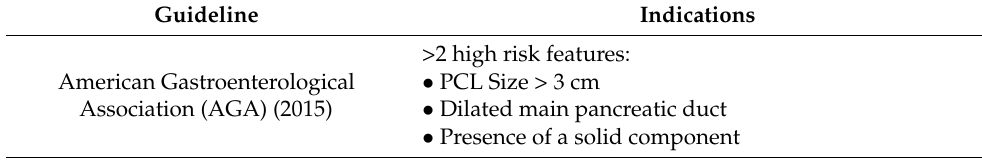
Table 1. Indications for Endoscopic Ultrasound